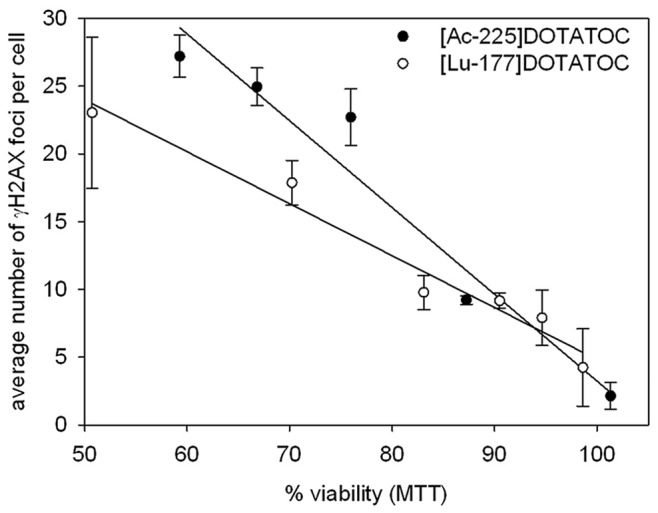
Comparison of cell viability and the number of γH2AX foci in AR42J cells at 48 h after incubation with 225Ac-DOTATOC and 177Lu-DOTATOC.